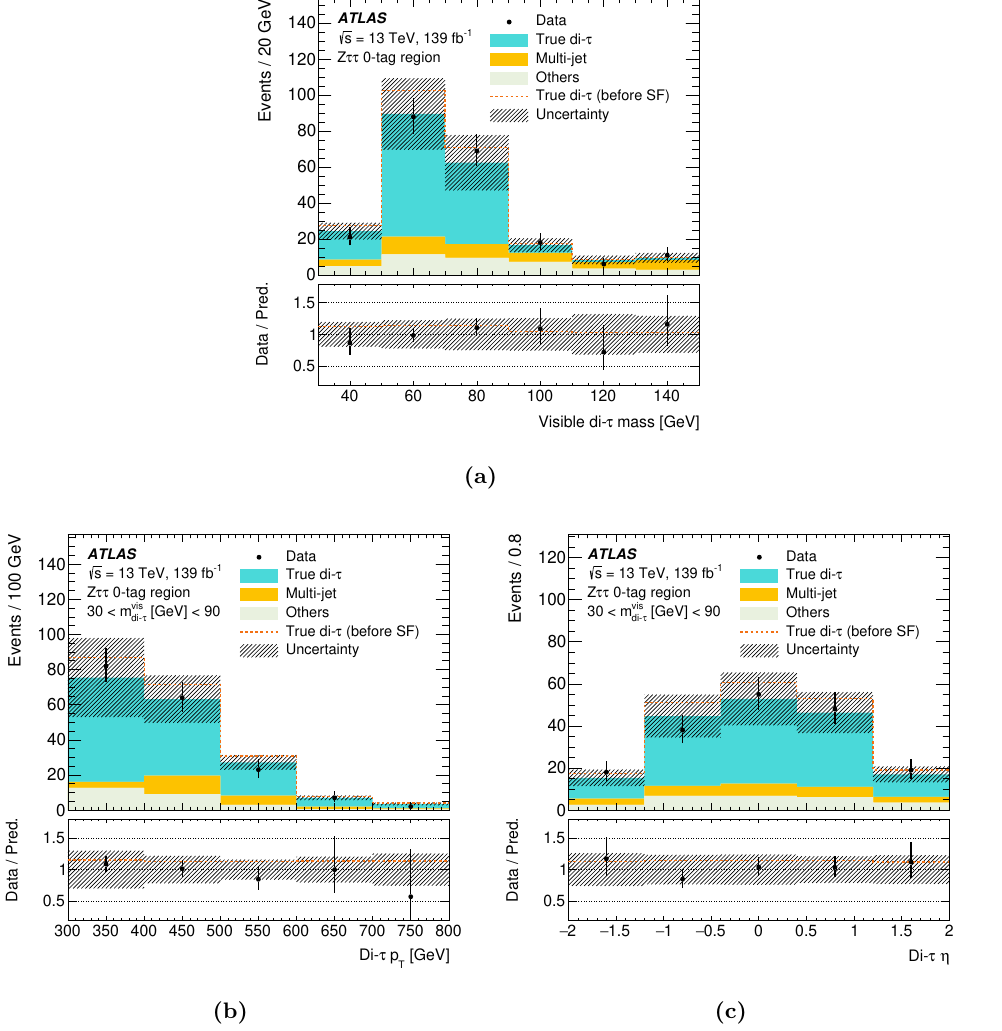
Figure 8. Distributions of (a) the visible mass of the di- τ object, (b) its p T and (c) η in the region labelled as ‘Z ττ 0-tag’ in table 2. All simulated events containing a generator-level τ + τ − pair matched to a simulated di- τ object are referred to as ‘True di- τ ’. The lower panels show a bin-by-bin comparison of the data and the predicted total background, in terms of event yield ratios. The hatched bands represent combined statistical and systematic